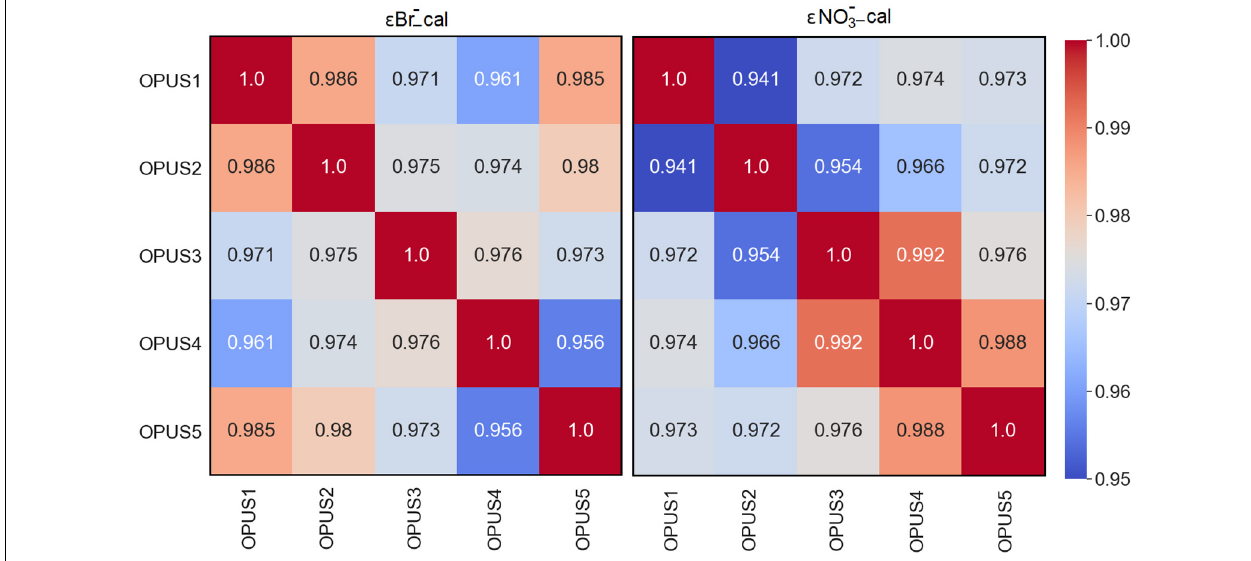
FIGURE 9 | Pearson’s correlation matrix for ε Br_cal and ε NO